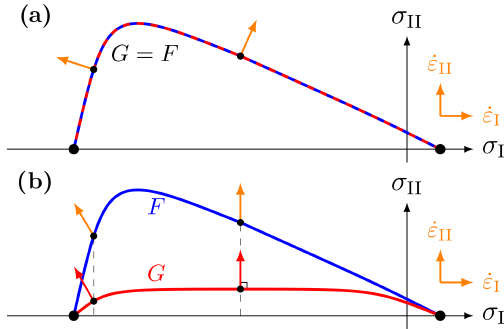
Figure 1. Schematic yield curve F (blue) and plastic potential G (red) for a normal (a) and non-normal (b) flow rule. The flow rule (orange) for a given stress on the yield curve is normal to the plas- tic potential (red) for the same σ I . Note that the stress and strain invariant axes are assumed to